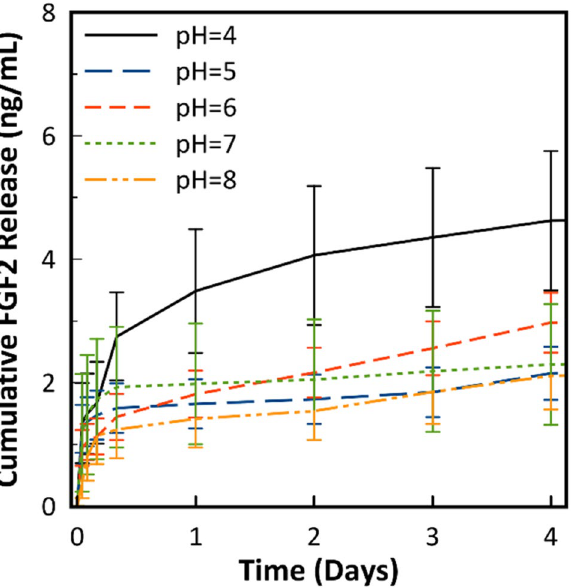
Figure 2. Cumulative FGF2 release over 4 days from FGF2-(PMAA/PLH) 5 PEMs. Released data was obtained by immersing 1 cm 2 substrates into 1 mL of PBS. 1 mL aliquots were taken and replaced over the course of 4 days. Error represents standard deviation (n = 5